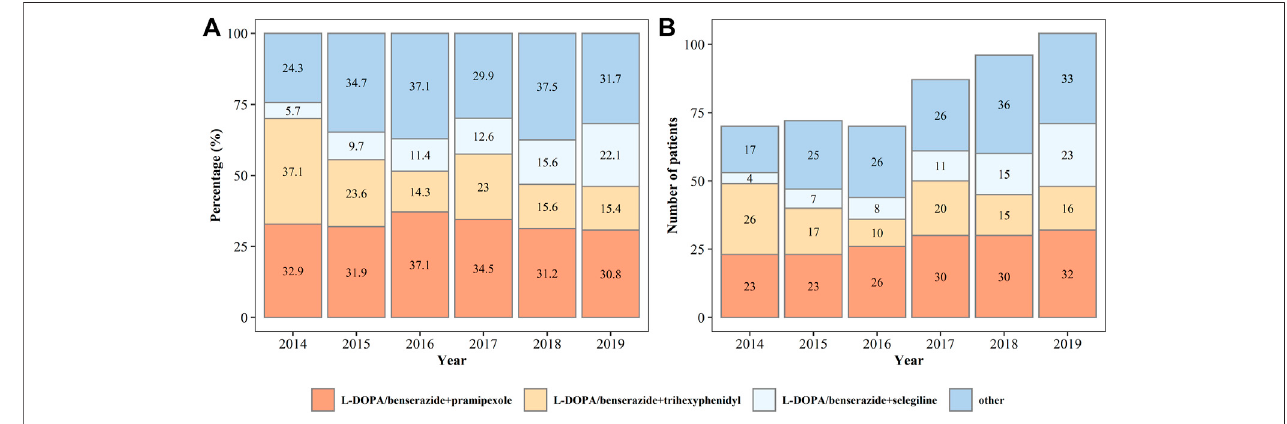
FIGURE 4 | The percentage (A) and number (B) of patients being prescribed two types of anti-Parkinson ’ s disease drugs from 2014 to 2019.